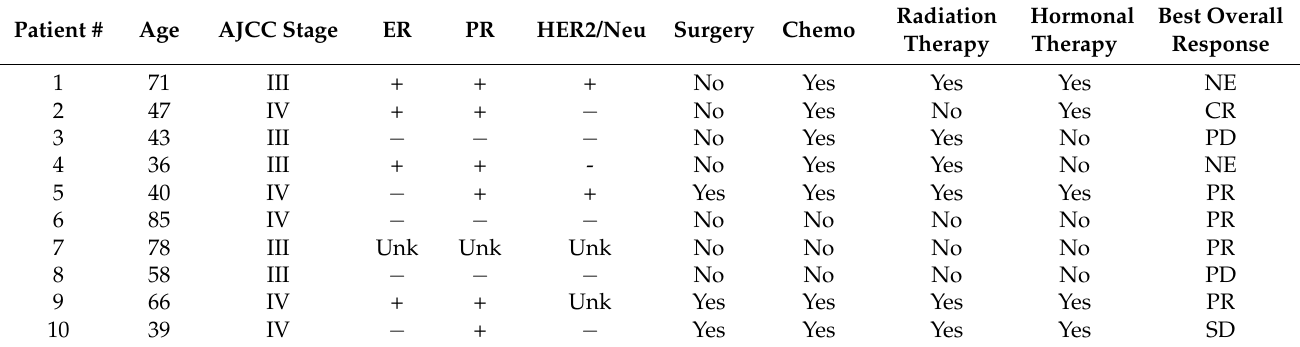
Table 1. Clinical characteristics of breast cancer patients treated with ablation + IP-001 in Peru.